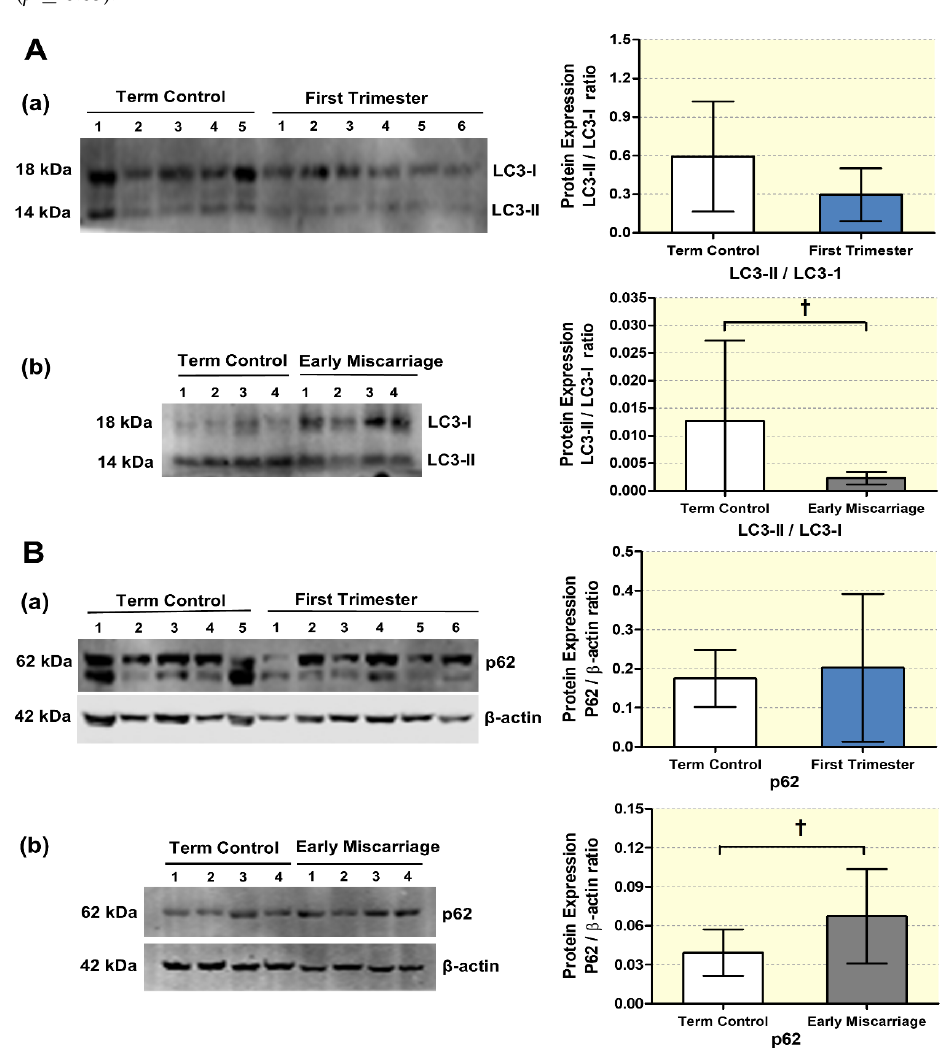
Figure 4. Protein expression changes in autophagy makers in placental tissues . ( A ) LC3-II, ( B ) p62 expression visualized by immunoblotting in placentae from ( a ) first trimester and term controls ( n = 6 and n = 5, respectively; Swiss cohort), ( b ) EMC patients and term controls ( n = 20 and n = 19, respectively) were quantified by fluorescence analysis and normalized to β -actin as loading control. Results of representative immunoblots for autophagy markers are shown. Reduction in the autophagy markers LC3II/LC3I and increased p62 were detected in EMC patients. Statistical analysis was performed by using two-tailed Mann – Whitney test for comparing first trimester vs. term controls (Swiss cohort) ( a ) and EMC vs. term controls ( b ); † ( p ≤ 0.01).